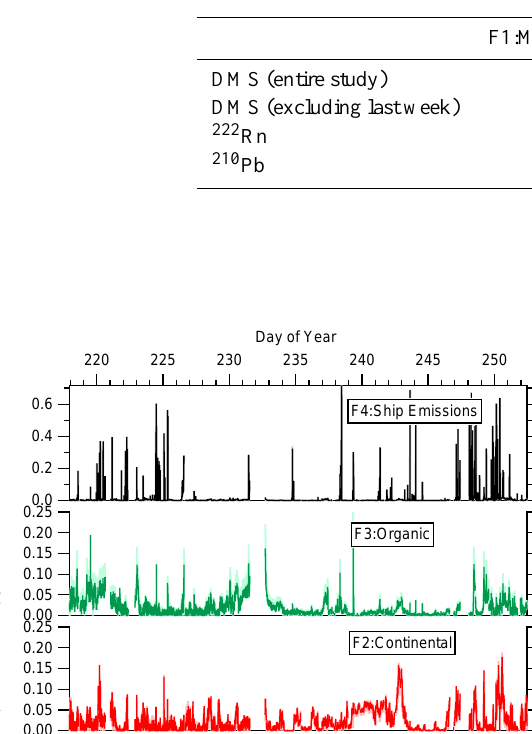
Table 4. Correlation coefficient of factor time series with external time traces.